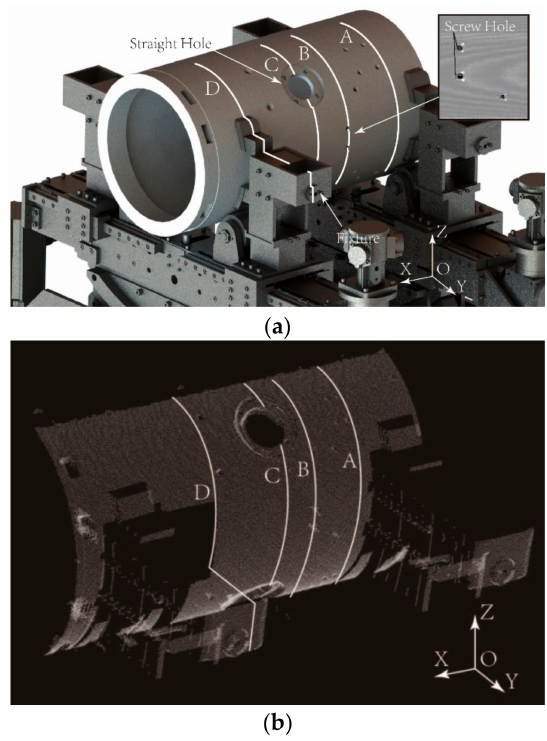
Figure 4. Measurement for the actual part with complex interferences: ( a ) diagram of the part on the support system; ( b ) point cloud obtained by the laser scanner.